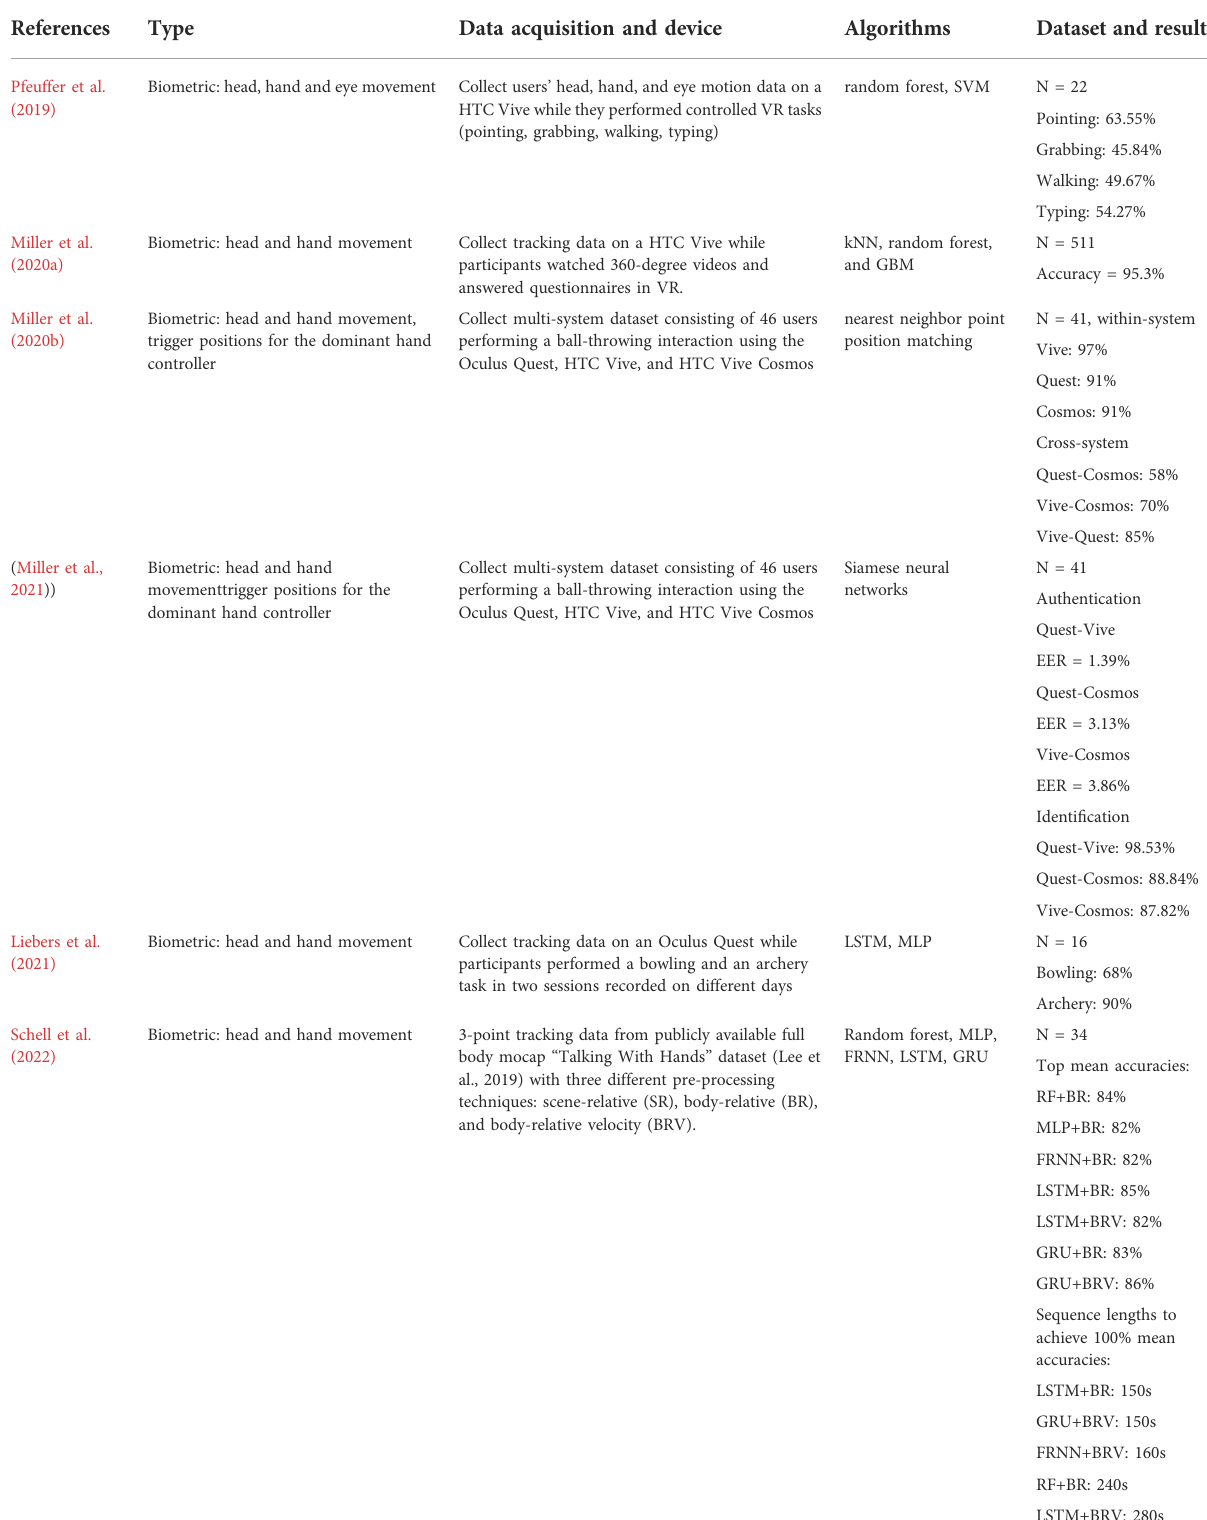
TABLE 5 An overview of six papers focusing on VR identi fi cation and/or authentication, that are not included in the reviewed of (Jones et al.,